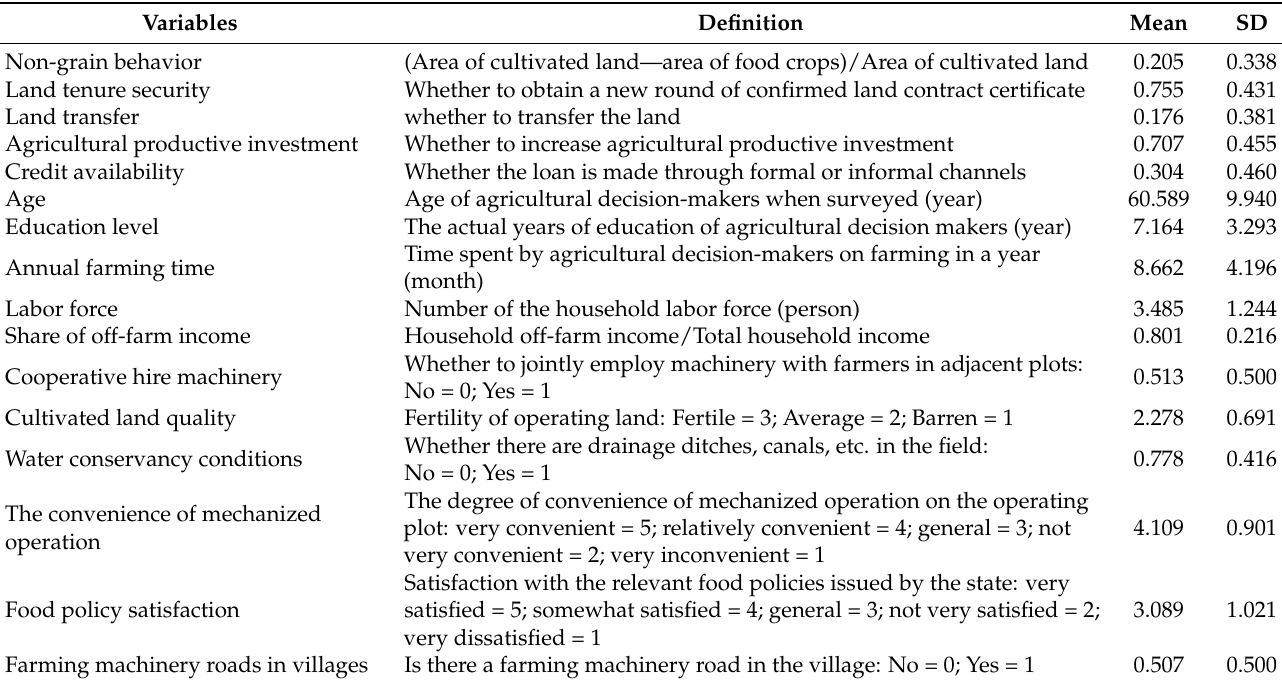
Table 1. Variable meaning and description